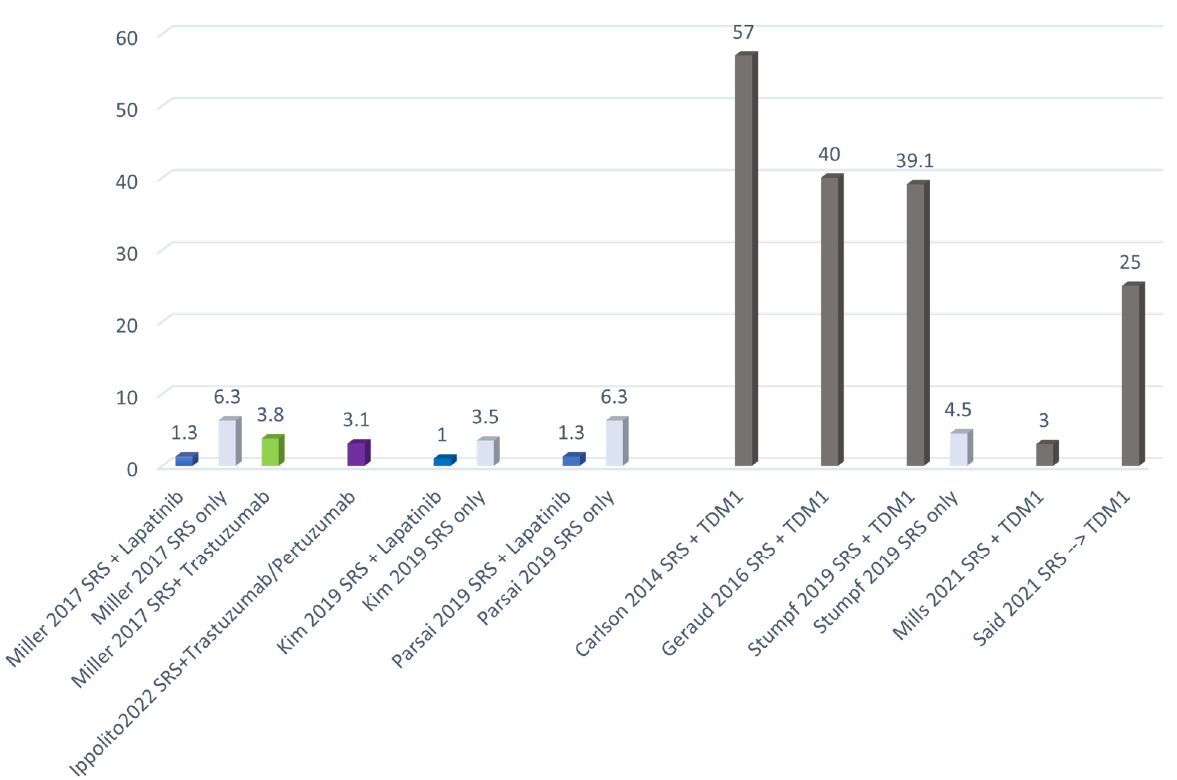
Figure 4. RN incidence reported in studies investigating the association between SRT and systemic therapies.